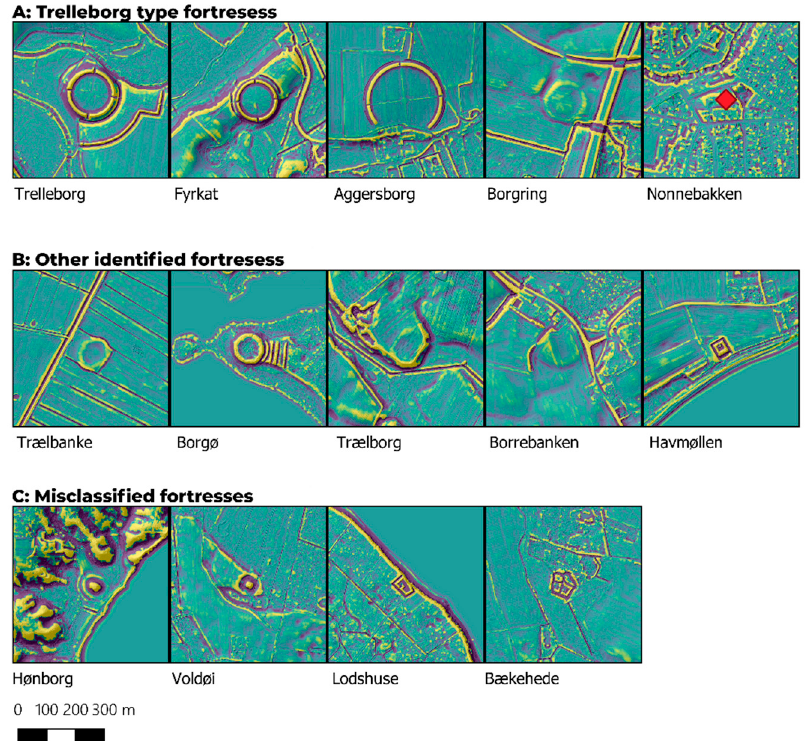
Figure 7. ( A ): The five known examples of Trelleborg-type fortresses in Denmark. Note that Trelleborg, Fyrkat, and Aggersborg have been extensively reconstructed and that Nonnebakken has been obliterated by modern development (location marked with a red diamond). ( B ): Further fortresses identified by the classifier. ( C ): The four fortresses misidentified by the classifier.